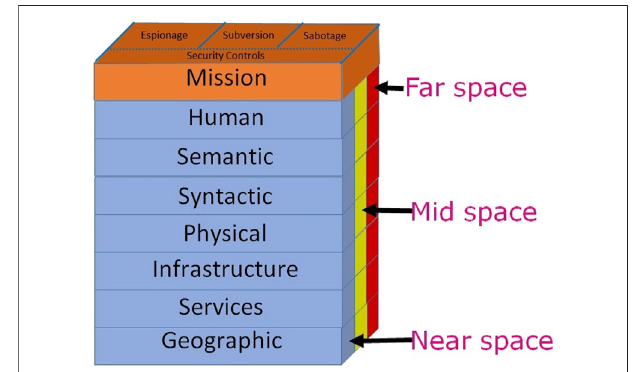
FIGURE 3 | The completed three-dimensional model of